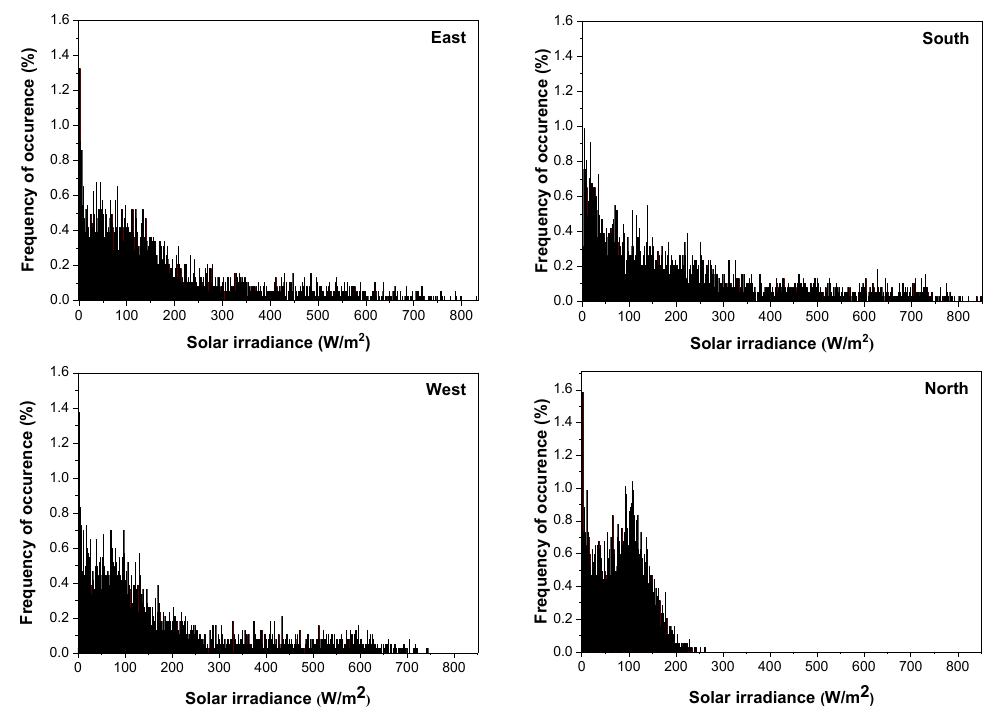
Buildings 2023 , 13 , x FOR PEER REVIEW Figure 8. Frequency of occurrence of vertical global solar radiation . Figure 8. Frequency of occurrence of vertical global solar radiation.